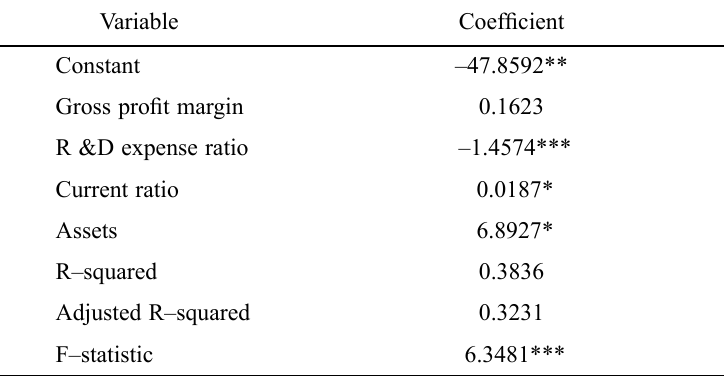
Table 10. Cross-sectional regression analyses of factors affecting CAR Variable Coefficient Constant –47.8592** Gross profit margin